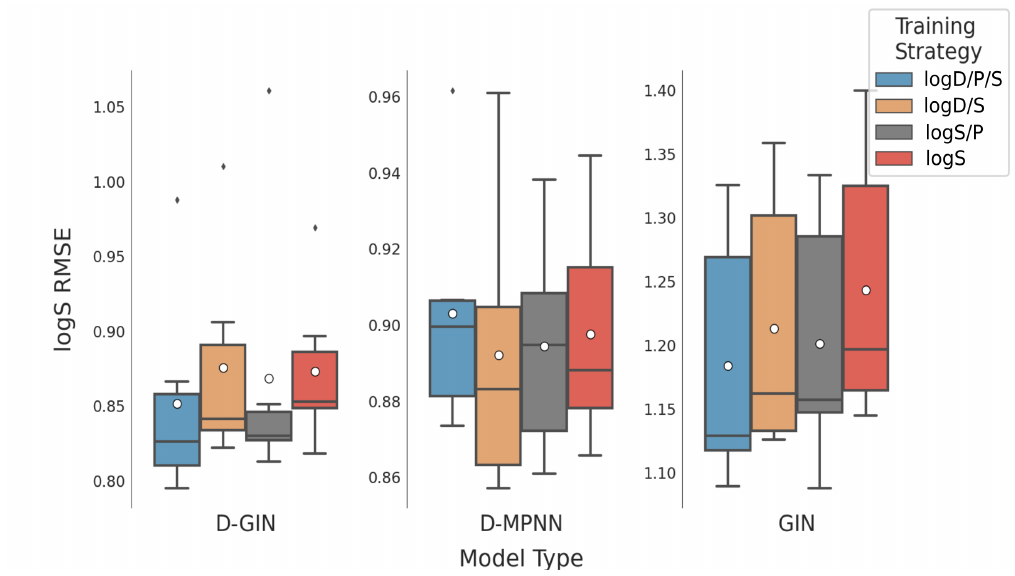
Figure 8. LogS prediction results for all GNN model types according to the used training strategy. The blue box shows the performance of the multi-task training strategy using logD, logS, and logP. The gray and orange box show the results utilizing a combination of logS and logP and logD and logS properties, respectively. The red box shows the results using logS for training. The mean is shown as a white dot whereas the median is shown as a dark gray line. Exact values are listed in Tables A12–A15 in the Appendix